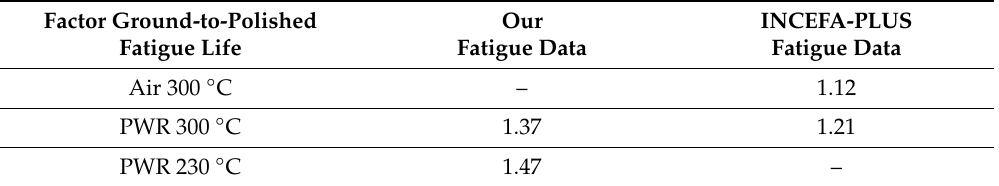
Table 6. Summary of surface finish